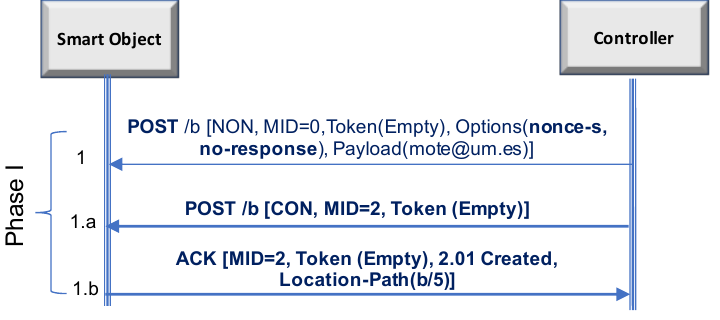
Figure 4. LO-CoAP-EAP